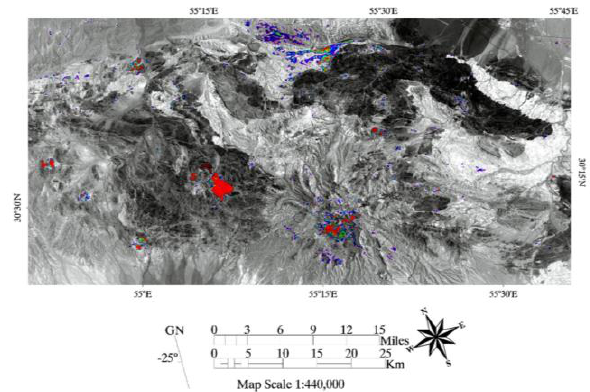
Figure 5. Al-OH Alteration intensity map of PC 4 driven from a DSPCA. Intensity of anomaly ranges from red color (strong anomaly) to blue color (weak anomaly).